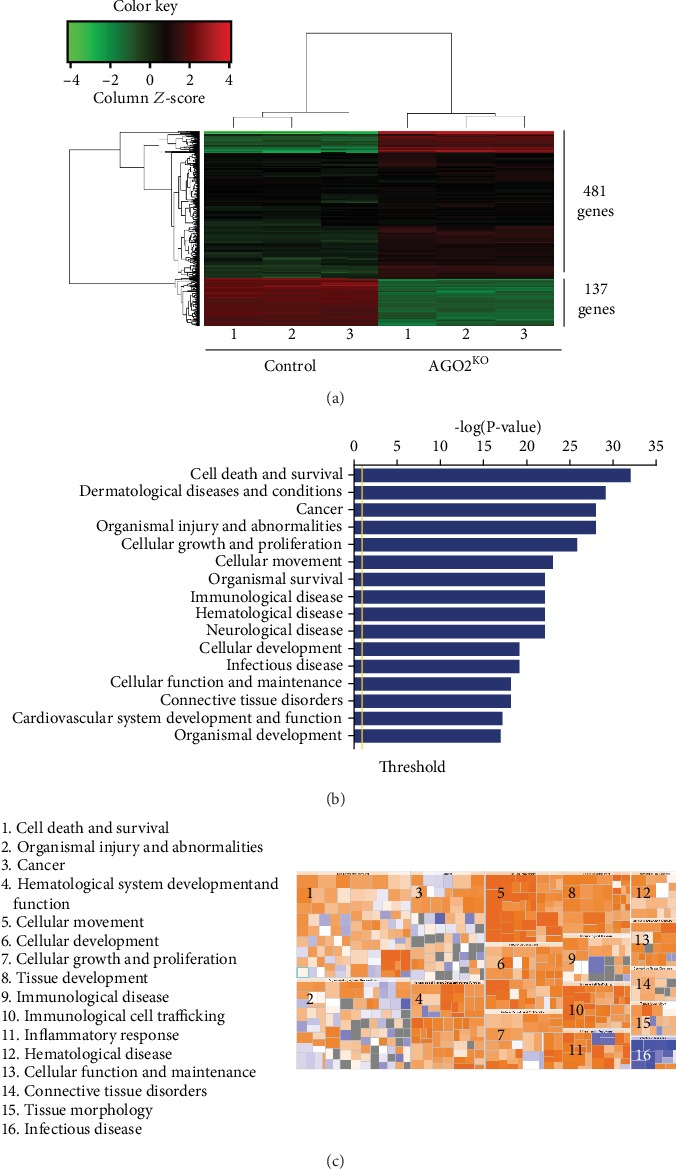
Bioinformatics analysis of microarray data. (a) The heat map of the pairwise comparison in control and AGO2 knockout SMMC-7721 cells. The colored bar shows the expression levels of genes. (b) Gene Ontology (GO) functional classification of differentially expressed genes (DEGs). The GO terms are shown in the bar chart of biological processes, cellular components, and molecular functions. (c) Heatmaps showed the upregulation and downregulation of DEGs associated with disease. Orange: Z‐score > 0, blue: Z‐score < 0, gray: no Z-score value. Z‐score > 2 indicates that the function is significantly activated, while Z‐score < ‐2 indicates that the function is significantly inhibited.